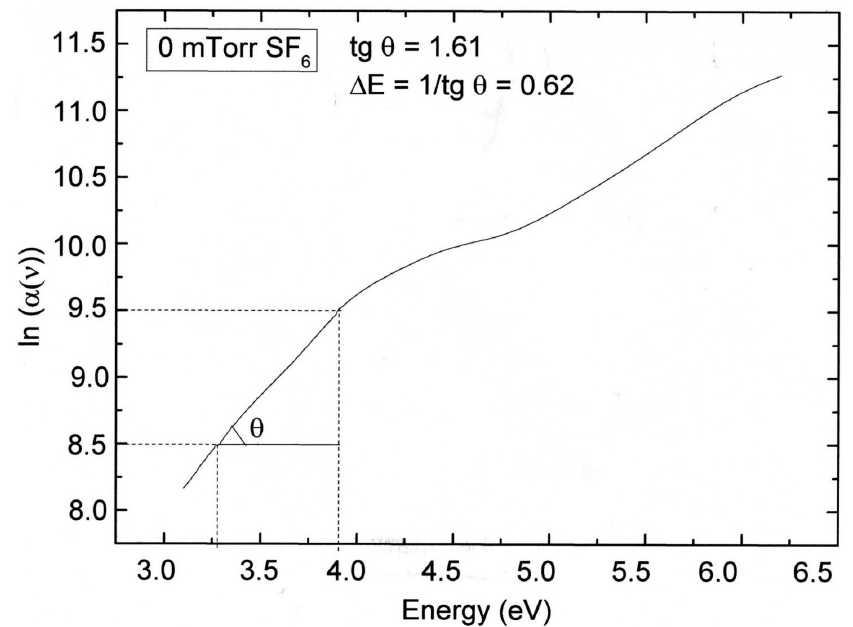
Figure 11. Example (of the unfluorinated film) of the graph allowing the calculation of the Urbach energy.